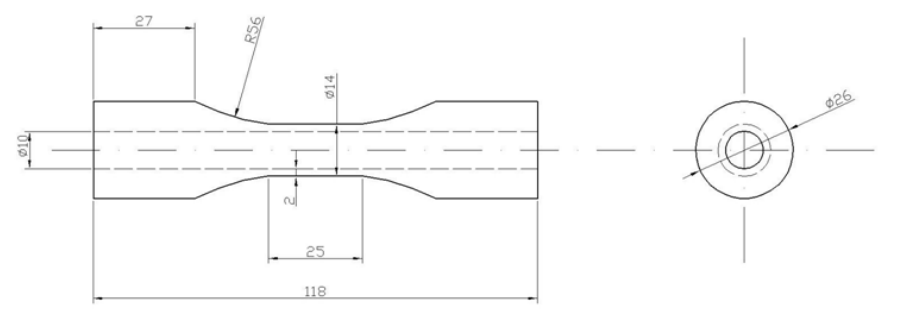
Figure 2: Geometry of the dog-bone shaped tubular hollow specimen used in the experiments. All dimensions are in